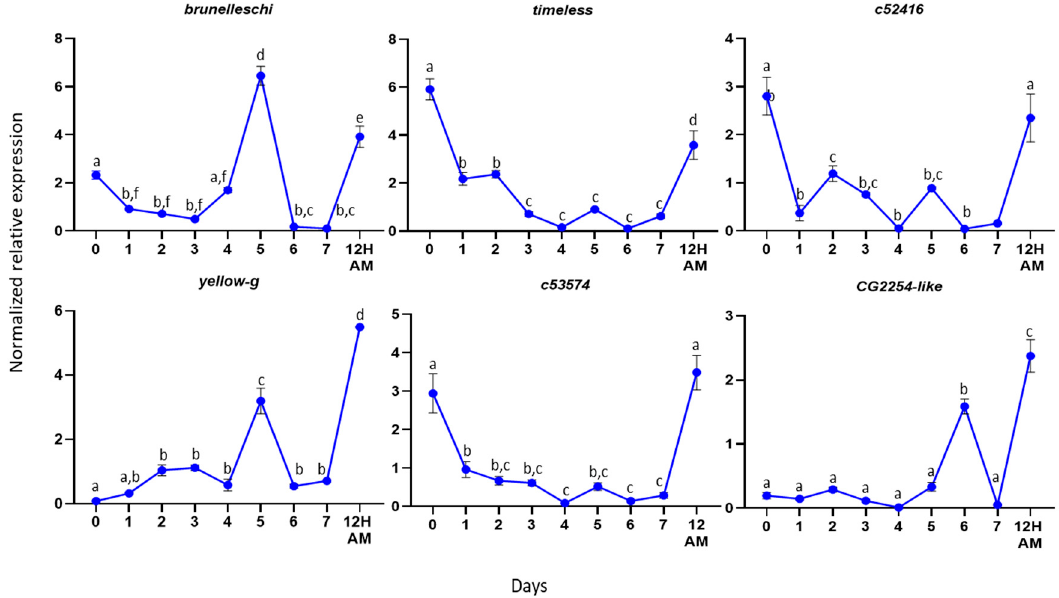
Figure 4. Expression profiles in male reproductive tissues. Expression profiles of the selected genes from the first day of hatching (Day 0) until Day 7. The error bars show the standard error of the mean between three biological samples. Small different letters next to the SD bars indicate statistically significant difference among different samples ( p < 0.05, one-way ANOVA with Tukey’s test).